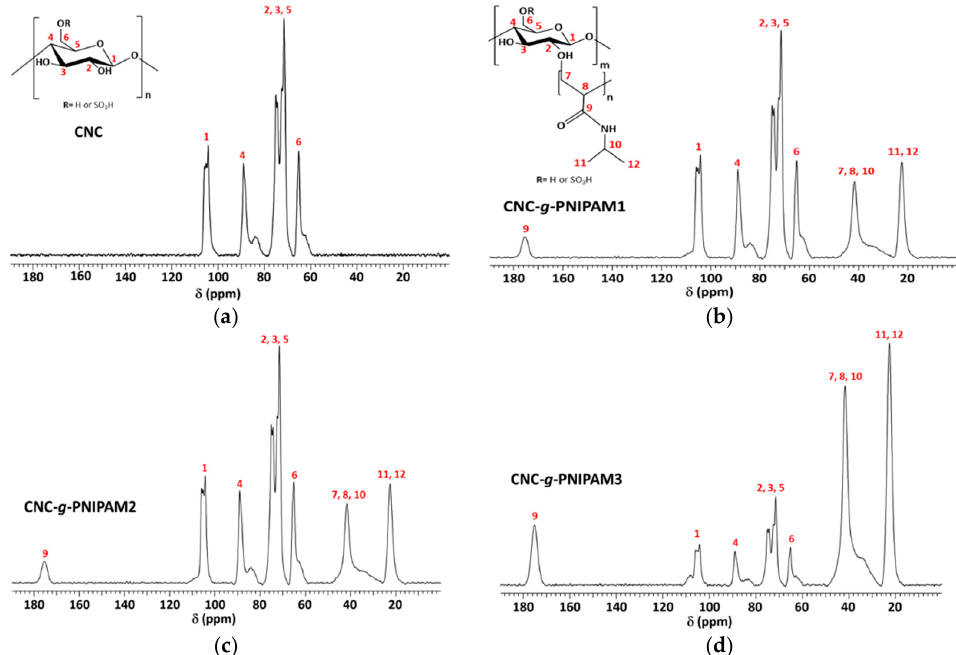
Figure 2. 13 C NMR spectra of ( a ) CNC; ( b ) CNC- g -PNIPAM1; ( c ) CNC- g -PNIPAM2; ( d ) CNC- g -PNIPAM3. X-ray diffractograms of cotton fibers (CFs), CNCs, and CNC- g -PNIPAM copolymers are shown in Figure 3. The index of crystallinity (IC) increased from 66.15% for CFs to 87.73% for CNCs, implying the preference for acid attack on the amorphous regions of cellulose [16,18,19]. The CFs and CNCs exhibited peaks at 2 θ of ~15°, 17°, 22.6°, and 34.5°,